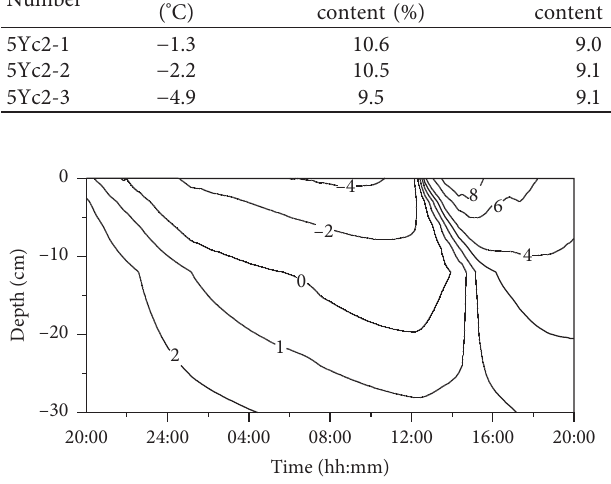
Figure 6: Changing process of ground temperature of the com- pacted gravelly soil without covering the thermal insulation ma- terials on the dam core wall from 20:00 on January 15th to 20:00 on January 16th, 2017 (unit: ° C).